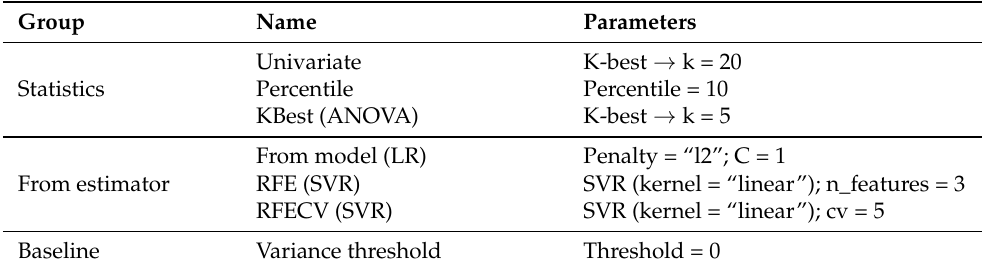
Table 4. Evaluated feature selection